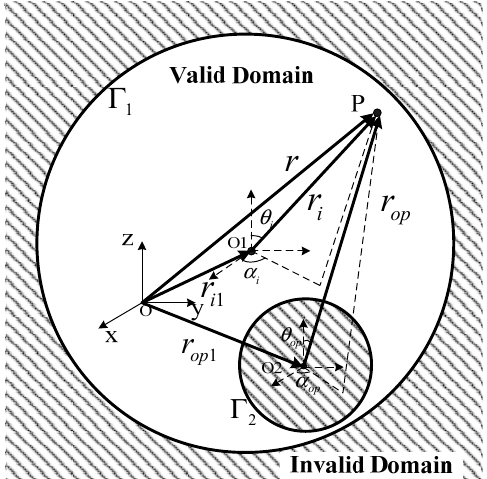
Figure 8. A field with two spherical